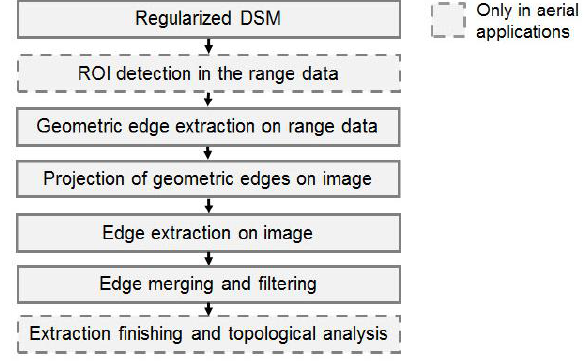
Figure 3. Integrated edge extraction workflow.